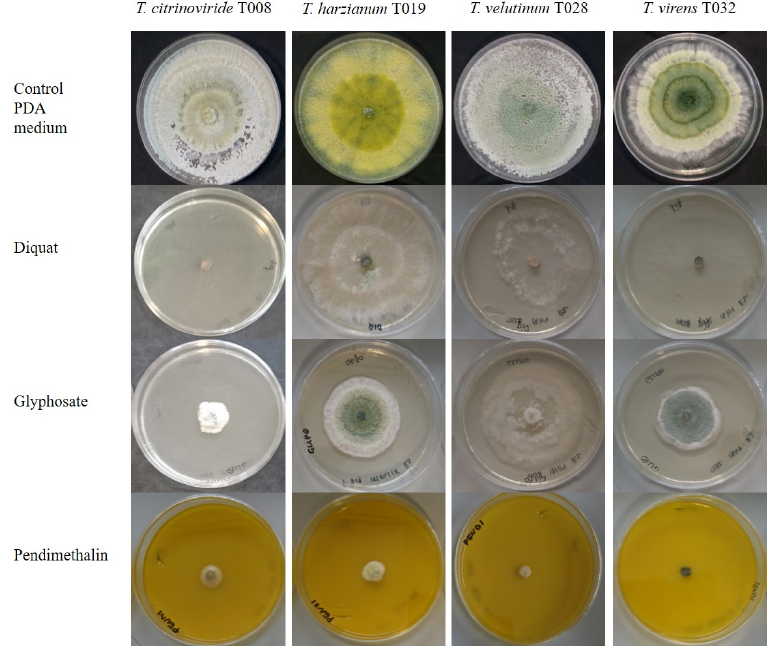
Figure 9. Growth of autochthonous Trichoderma strains in medium with synthetic herbicides at day 5 after inoculation.